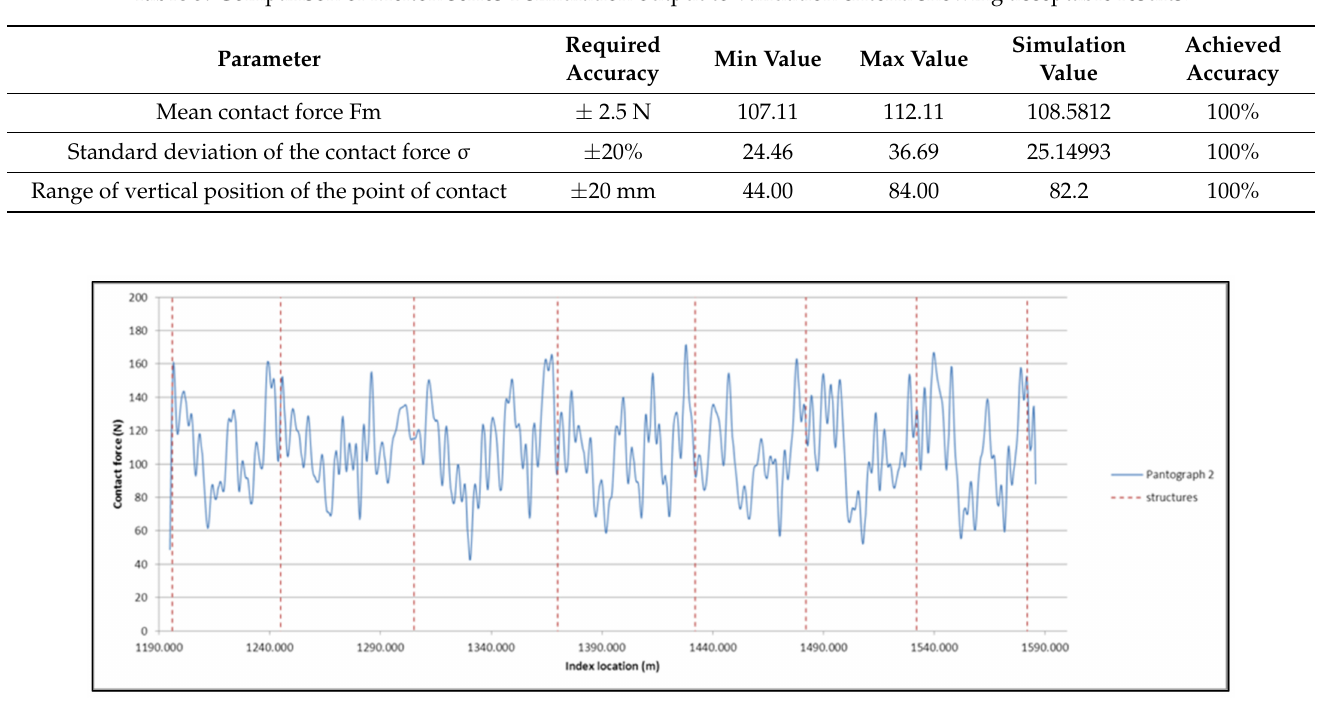
Figure 16. Simulation of Melton Series 1 tests output showing the contact force filtered at 20